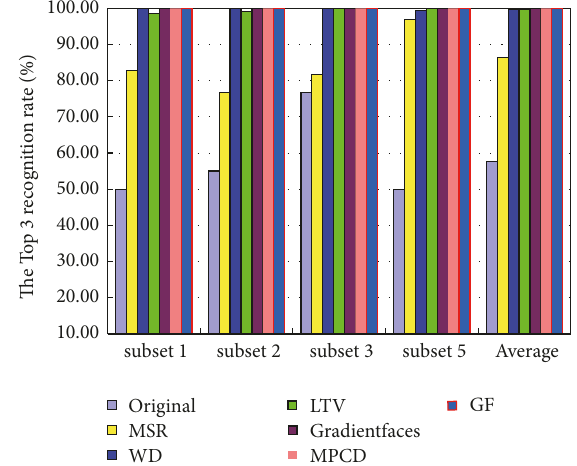
Figure 8: Comparisons on the Top 3 recognition rate (the subset 4 used as the training